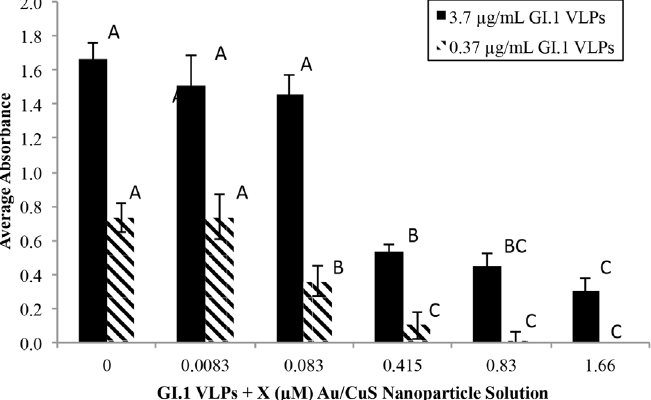
Fig 1. Effect of Au/CuS NP concentration on VLP solution absorbance. Absorbance was measured using the three-hour ELISA, and all solutions contained an equal volume of NPs. Reduced absorbance indicates structural damage to the capsid surface proteins and associated VLP inactivation. In each series, the same letters on the columns indicate no statistically difference, and the different letters indicate statistically different.